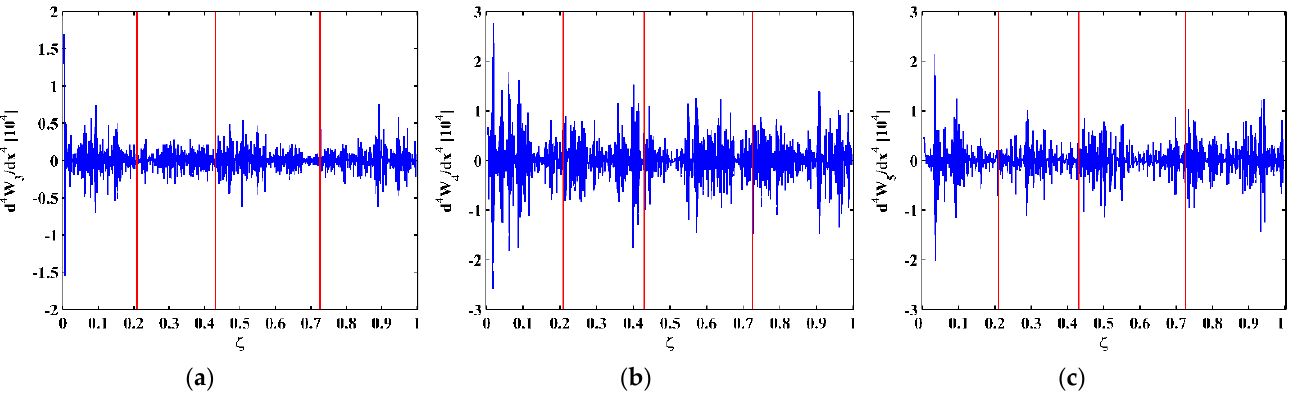
Sensors 2021 , 21 , x FOR PEER REVIEW Figure 14. The ( a ) third, ( b ) fourth, and ( c ) fifth mode shapes (locations of cracks are indicated by red lines).